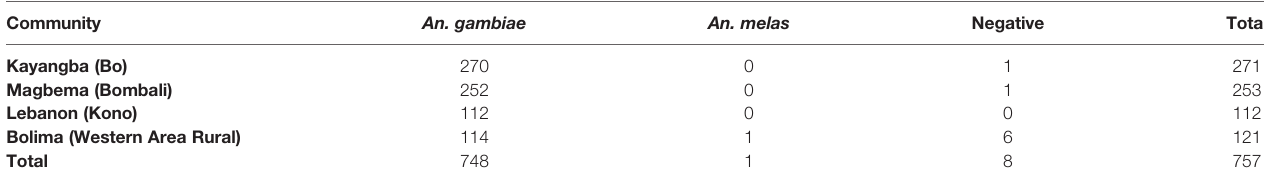
TABLE 3 | PCR authentication for the members of the An. gambiae complex.